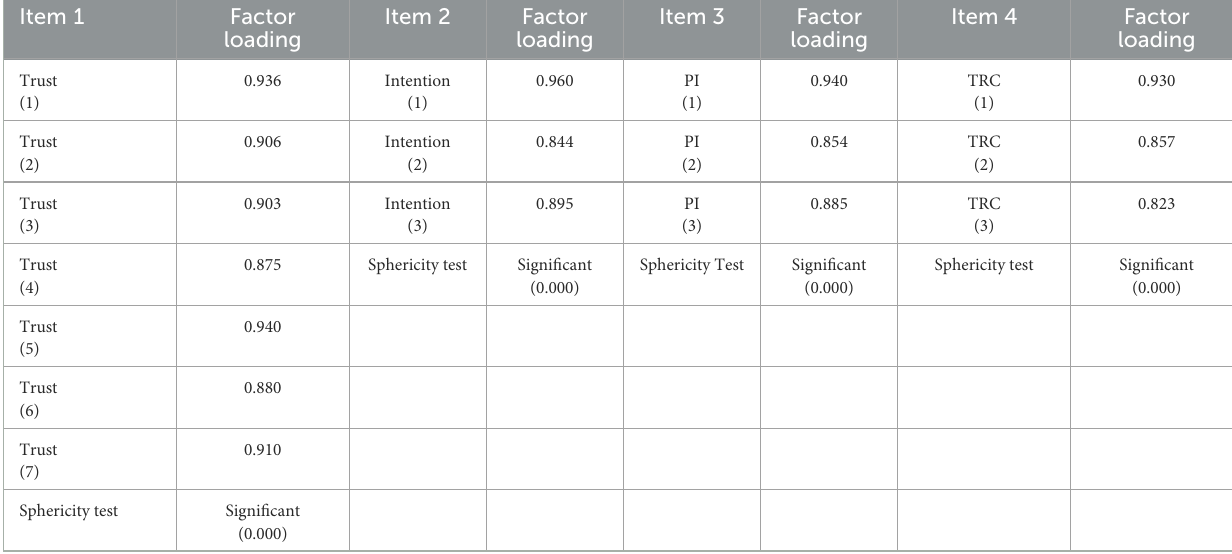
TABLE 2 Factor analysis results (validity test).